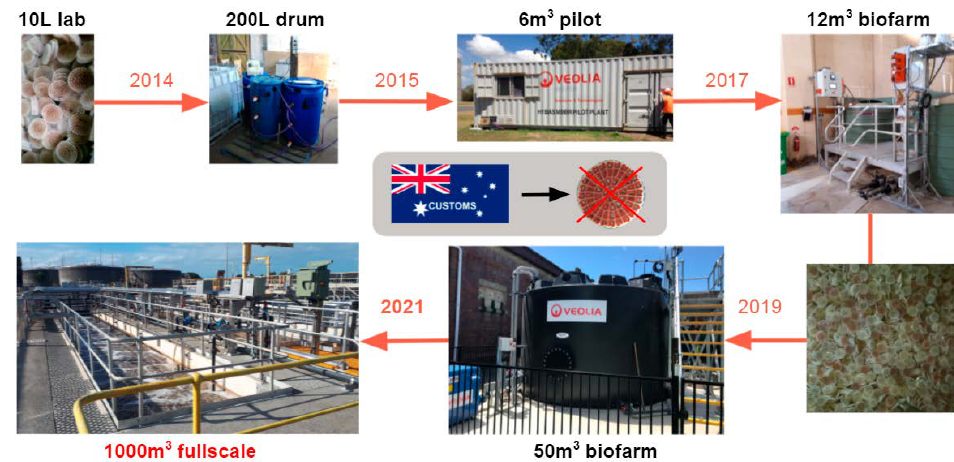
Figure 7. Scale-up journey to grow anammox bacteria locally for 1st ANITA Mox in